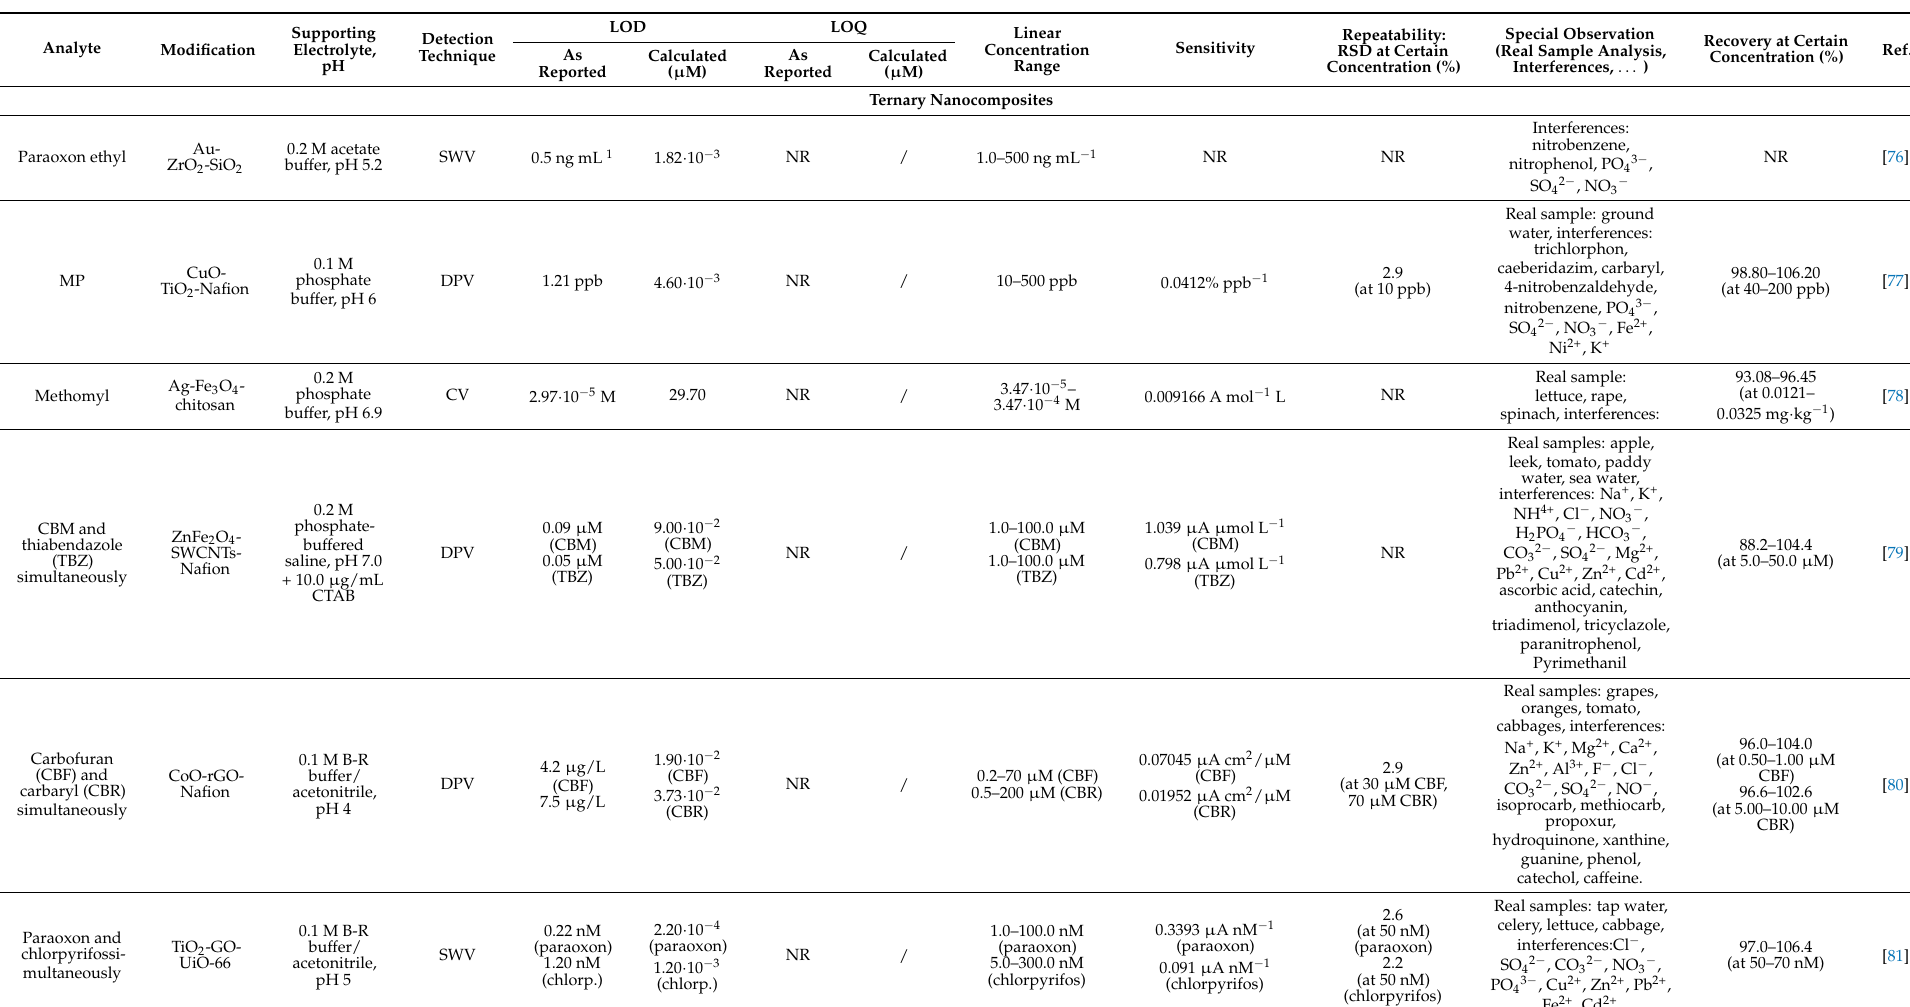
Special Observation (Real Sample Analysis, Interferences, ...